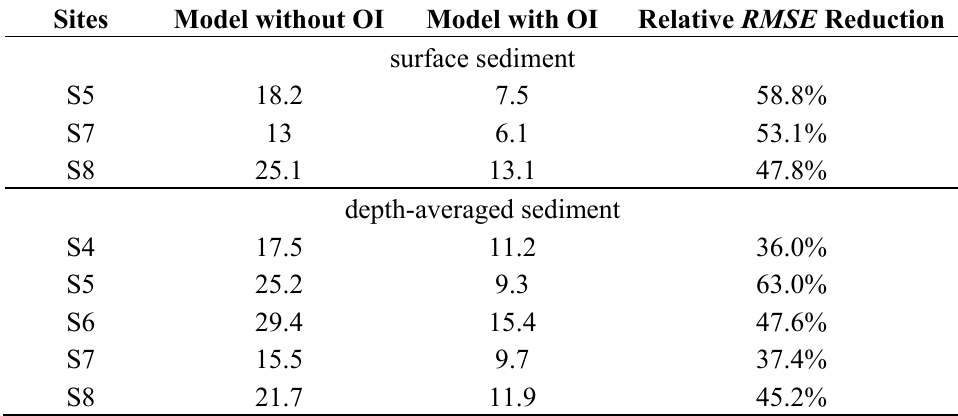
Table 4. Statistics of RMSE (mg/L) over surface sediment concentration and